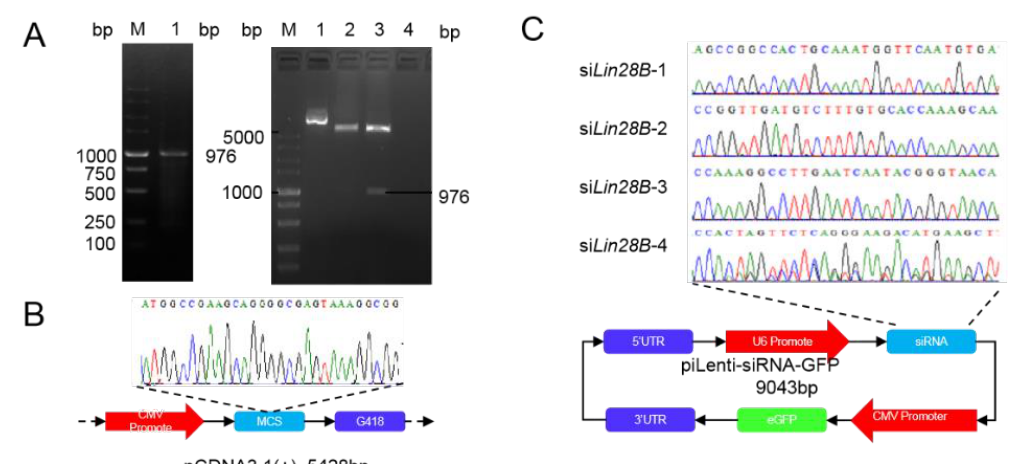
Figure 1. Construction of overexpression and interference vector of Lin28B . ( A ) Left: cloning results of Lin28B ,1: Lin28B amplification bands, M: DL5000 marker; Right: double digestion results of Lin28B overexpression vector, M: DL 5000 marker; 1: no enzyme digestion; 2: single enzyme digestion; 3: double enzyme; 4: ddH 2 O. ( B , C ) Construction schematic diagram of Lin28B overexpression and interference vector.